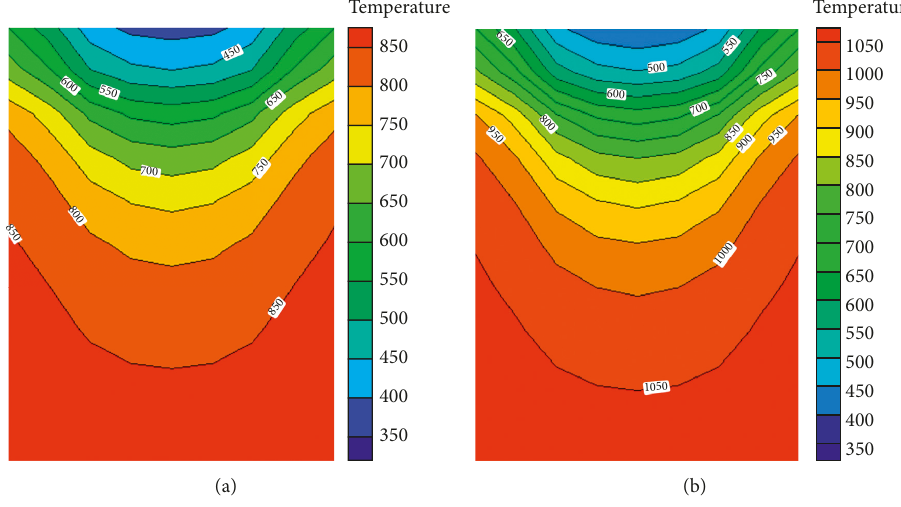
Figure 7: Isotherm contour of section 150mm